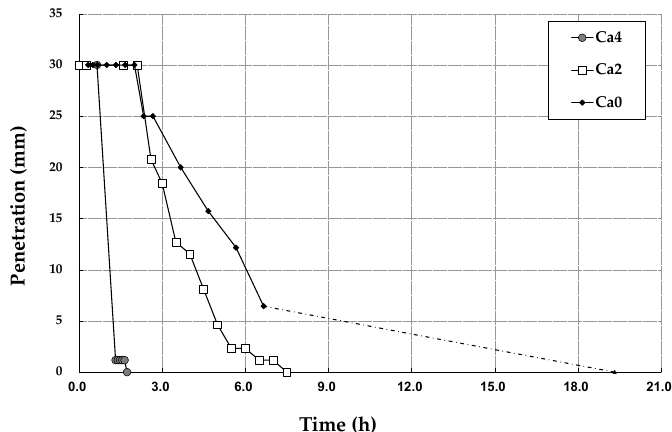
Figure 2. Setting behavior of metakaolin-based geopolymers. The addition of 4% calcium hydroxide promoted a fast set by interlocking coagulate products from the outset.